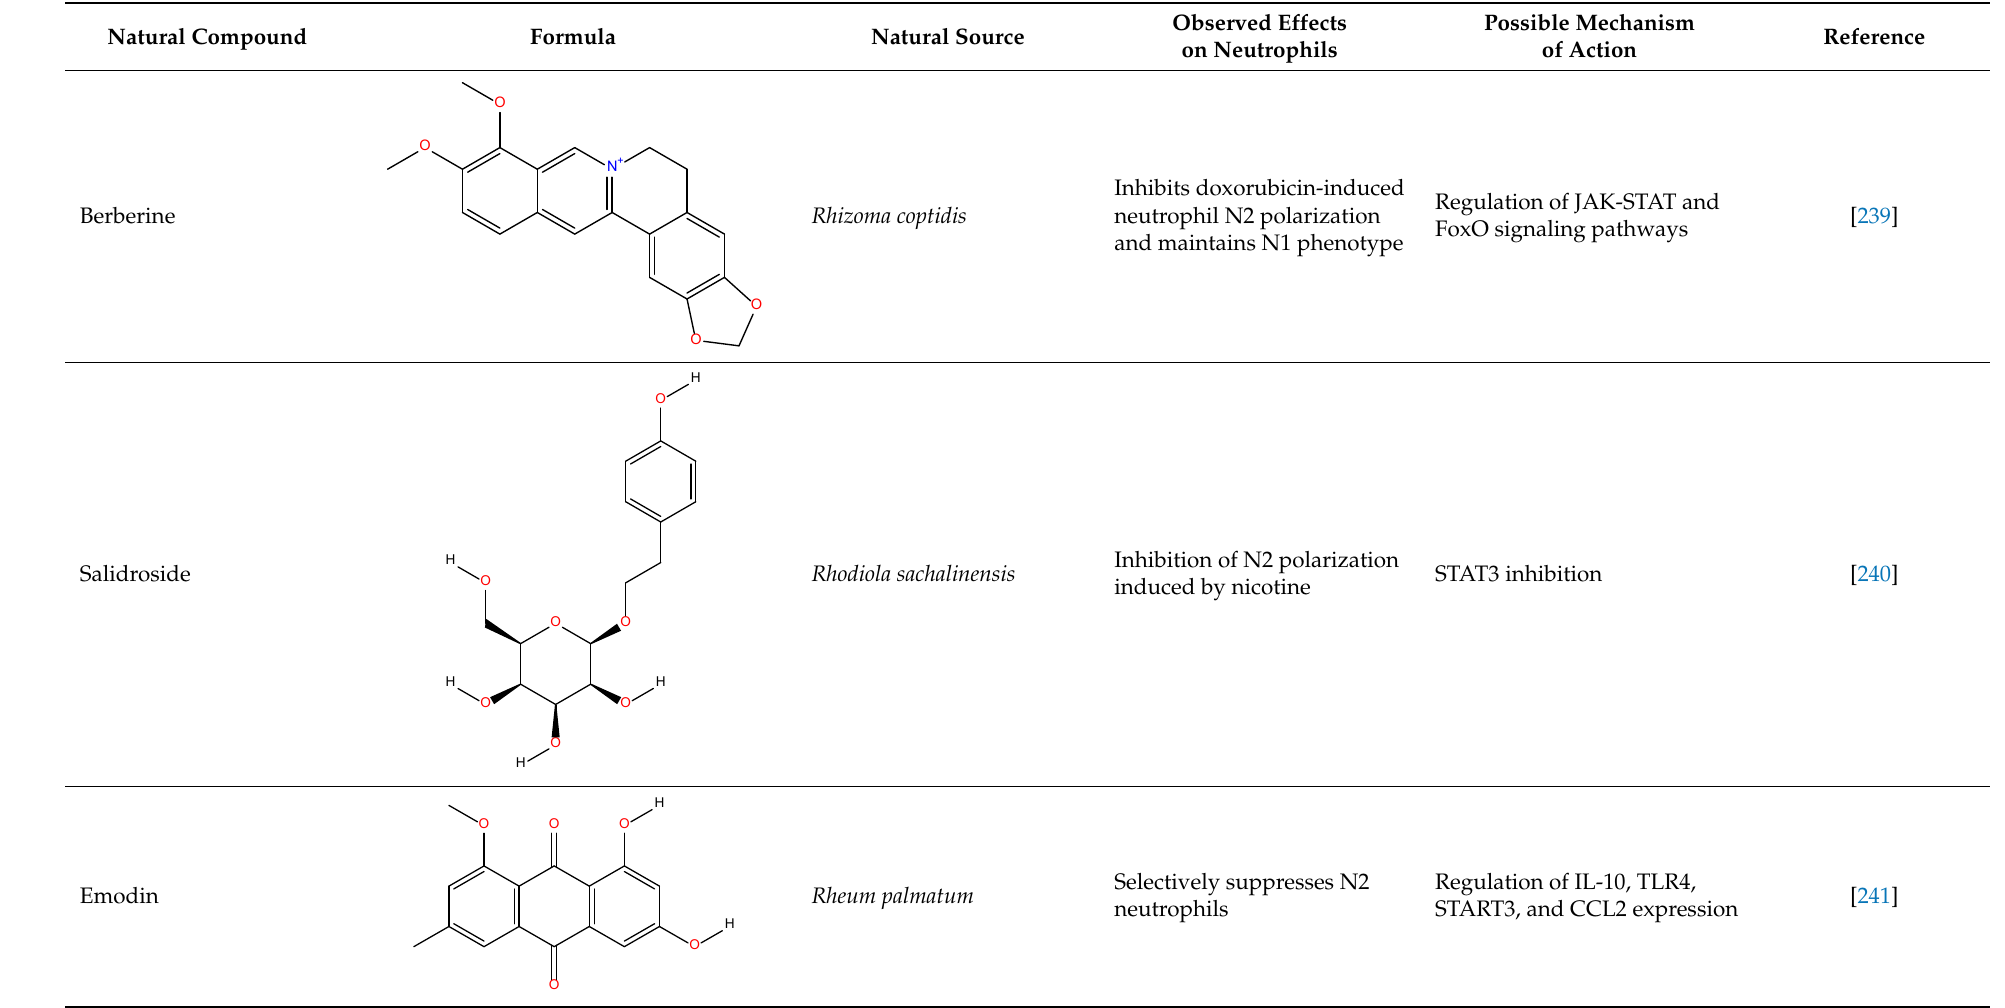
Table 3. Natural compounds with demonstrated effects on neutrophil polarization.